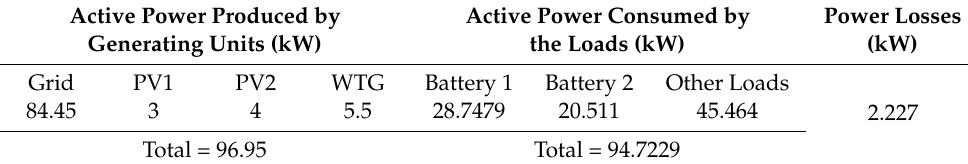
Table 2. The power production and the power consumption in case of grid connected. Active Power Produced by Generating Units (kW)